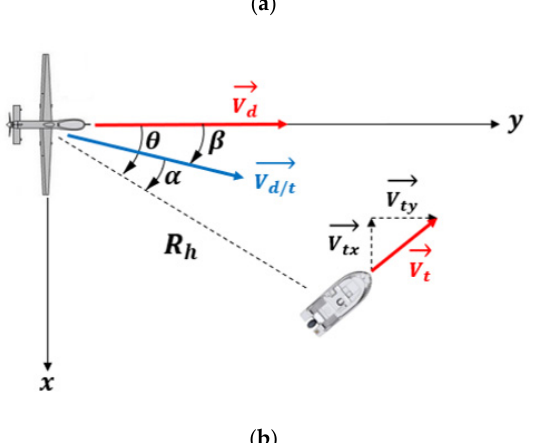
Figure 13. UAV and target motions geometry: ( a ) oblique view, ( b ) top view.